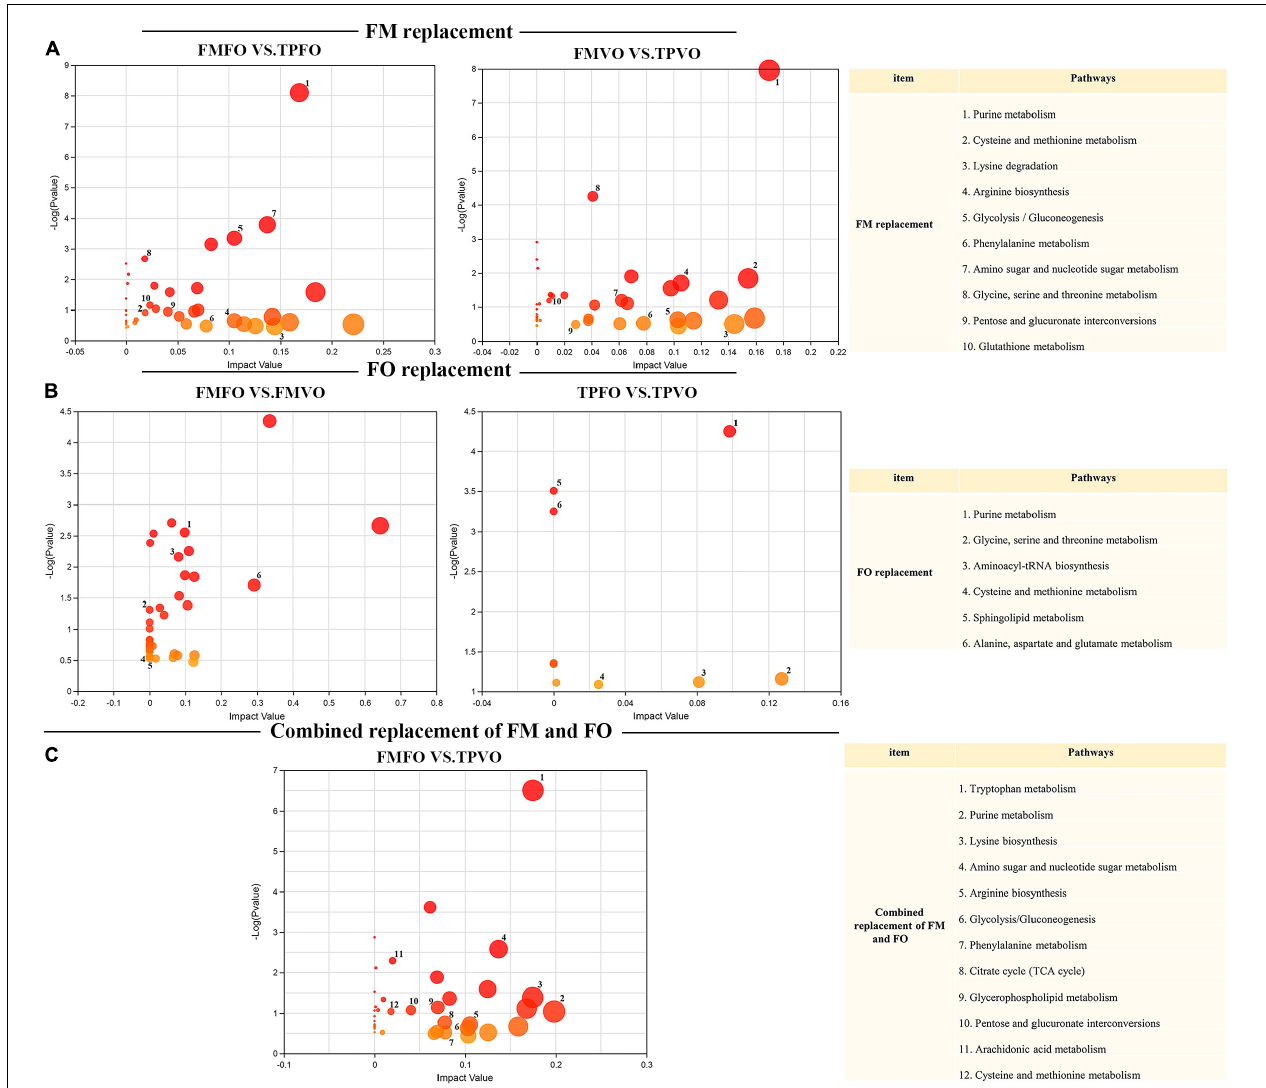
FIGURE 3 | Significant specific pathway identified by multi-omics analysis between FM or FO replacement and combined replacement FM and FO. Pathway analysis of DMs from common pathways shared with DEGs was plotted at the replacement of FM (A) , replacement of FO (B) , and combined replacement of FM and FO (C) . Map00230: purine metabolism; map00310: lysine degradation; map00220: arginine biosynthesis; map00010: glycolysis/gluconeogenesis; map00360: phenylalanine metabolism; map00520: amino sugar and nucleotide sugar metabolism; map00260: glycine, serine, and threonine metabolism; map00040: pentose and glucuronate interconversions; map00480: glutathione metabolism; map00380: tryptophan metabolism; map00020: citrate cycle (TCA cycle); map00564: glycerophospholipid